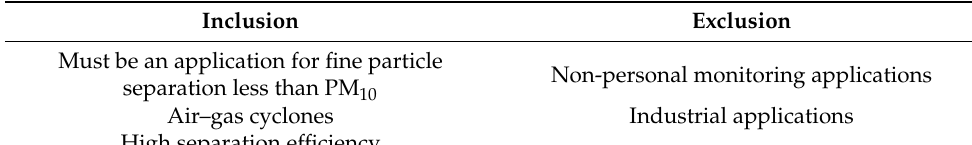
Table 2. Inclusion and exclusion criteria.